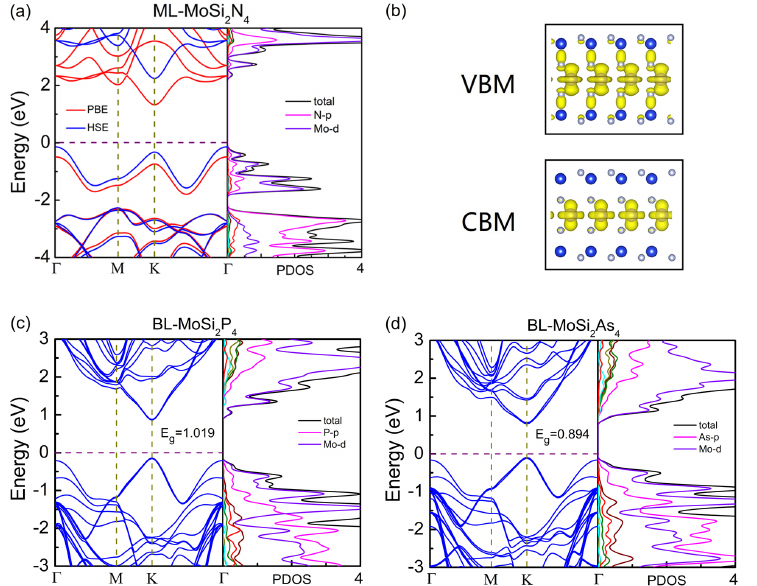
Figure 5. ( a ) The electronic band structure and PDOS of monolayer MoSi 2 N 4 , ( b ) Corresponding charge distribution at VBM and CBM of monolayer MoSi 2 N 4 . The electronic band structure and PDOS of bilayer ( c ) MoSi 2 P 4 and ( d ) MoSi 2 As 4